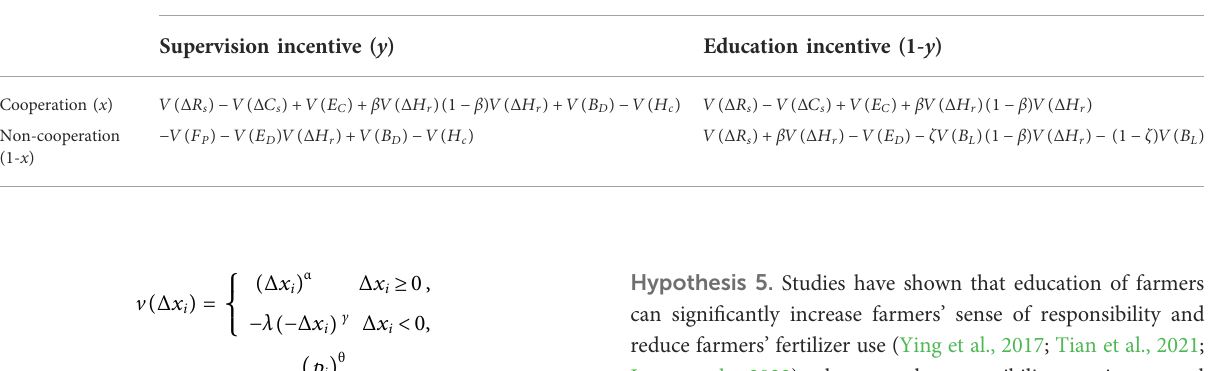
TABLE 1 Income matrix of cooperatives and small farmers. Small farmers